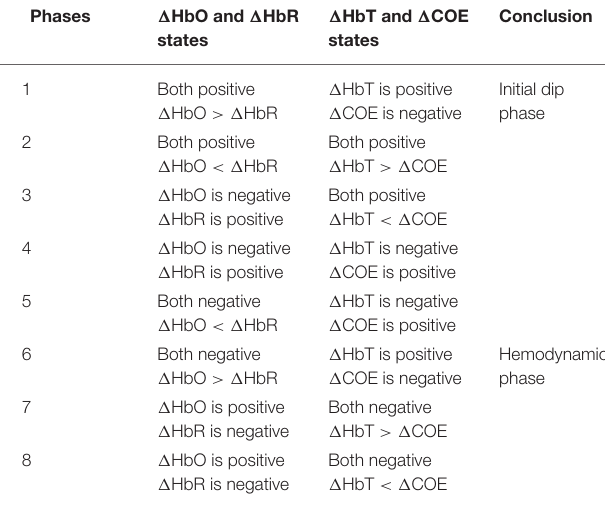
TABLE 2 | Vector phases for initial dip and hemodynamics (Hong and Naseer,